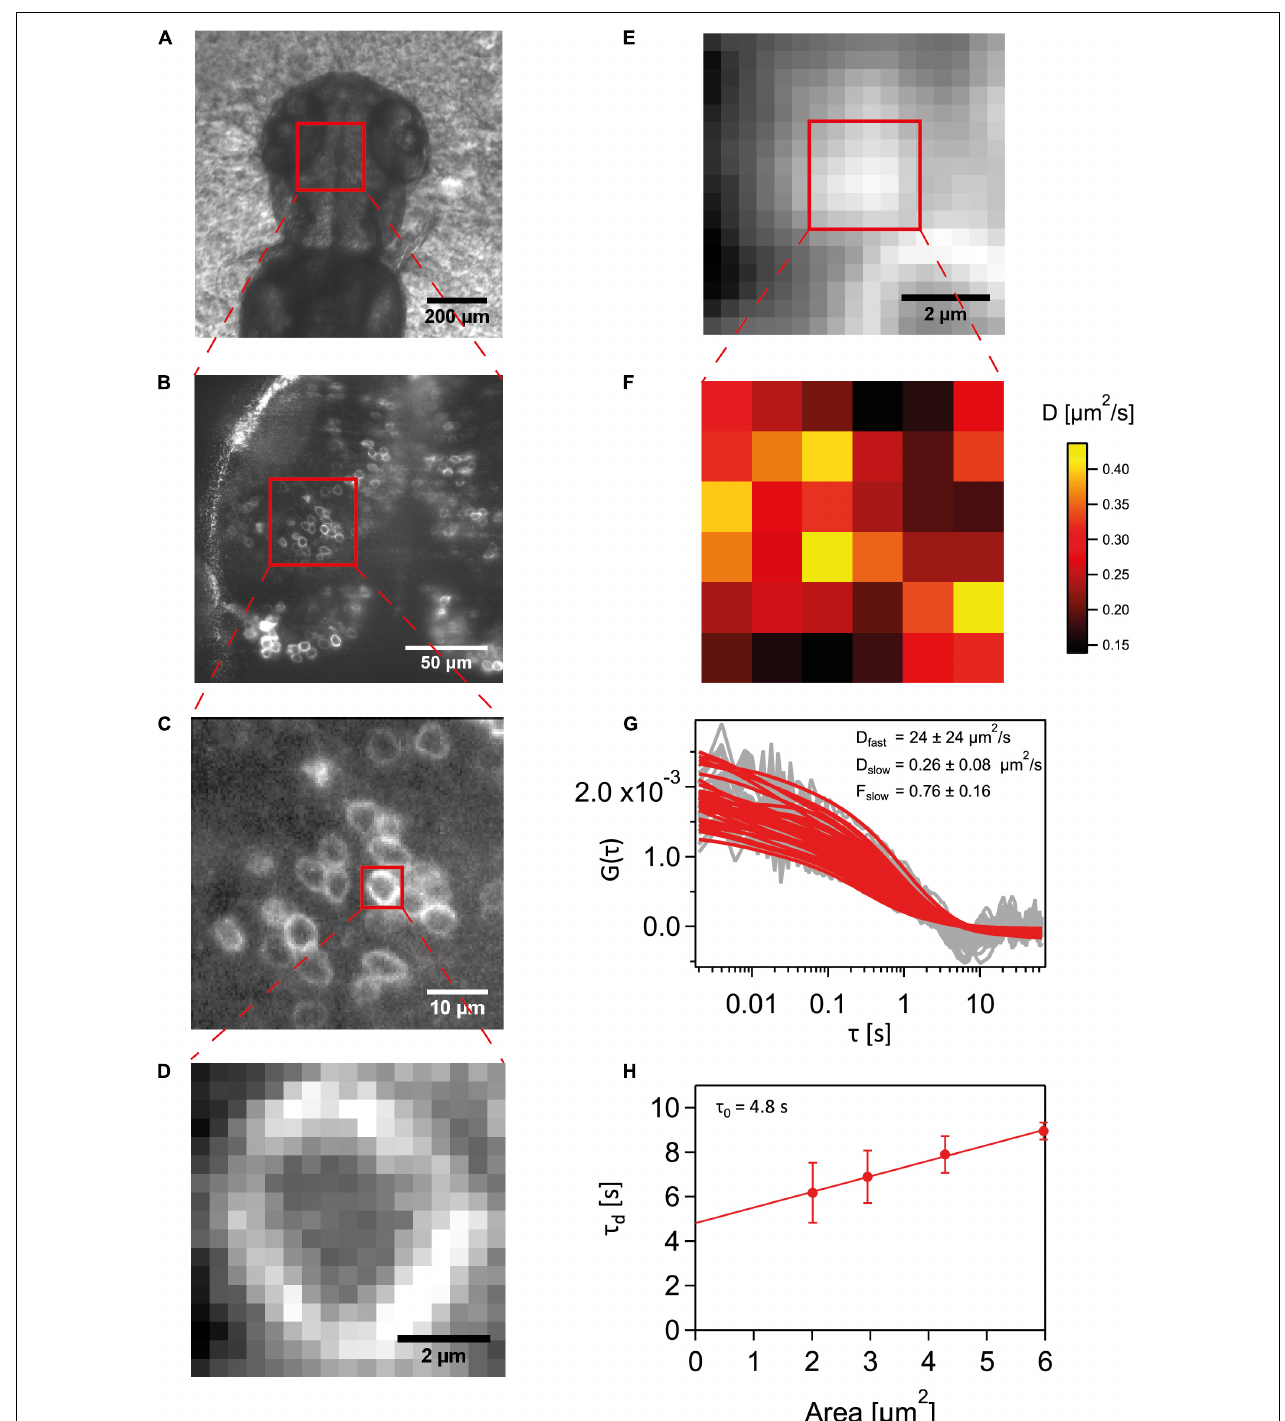
FIGURE 1 | Schematic for a SPIM-FCS experiment. (A) A stereomicroscope image of the dorsal region of a 2-3 dpf Wnt3-EGFP expressing embryo. (B) sCMOS camera image capturing a large field of view of Wnt3-EGFP expressing cells at the midbrain-anterior hind brain region. (C) EMCCD camera image of a smaller subregion expressing Wnt3-EGFP fluorescent cells. (D) Cropped detector region of the imaging area with only a single cell in view. (E) A summed-up intensity projection of the 100,000 frames imaging the apical membrane of the cell imaged in (D) . (F) A 6 6 subregion’s slow component diffusion coefficient map obtained from the fit values of the ACFs. (G) The raw autocorrelation data in gray and their corresponding fits in red. (H) Diffusion law plot for the 6 6 region to obtain the τ 0 intercept value.